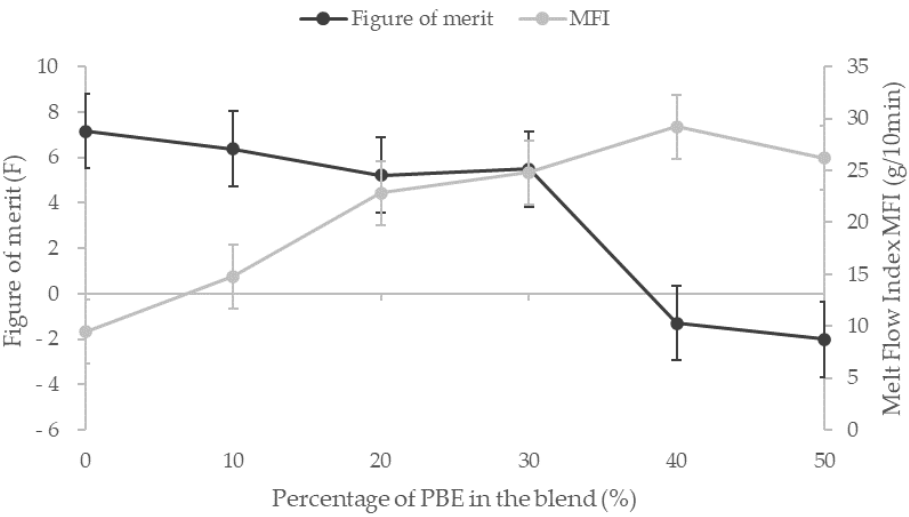
Figure 10. Influence of the proportion by weight of PBE on the Melt Flow Index and on the figure of merit, which gathers the elongation at break and the sensitivity of the blends.